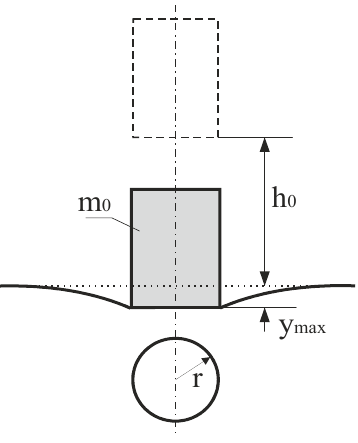
Figure 2. Contact between a rigid cylinder and an elastic half-space.